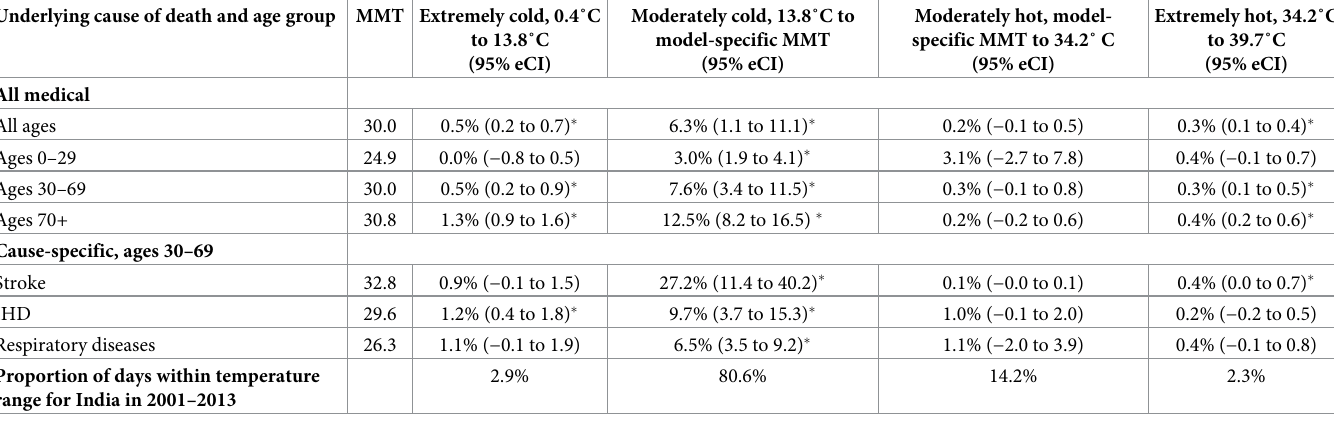
Table 1. Mortality risks attributable to hot and cold ambient temperatures in India. Underlying cause of death and age group MMT Extremely cold, 0.4˚C